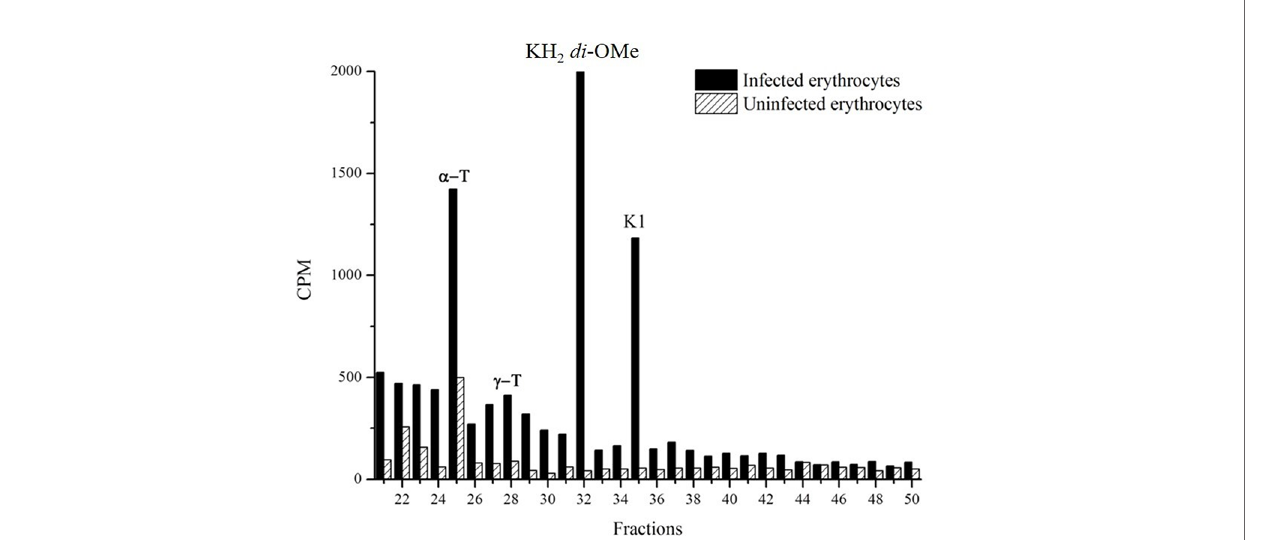
FIGURE 4 | Detection of methylated hydrophylloquinone. The hydrophylloquinone were stabilized by adding methyl iodide in infected erythrocytes extract labeled whit [ 3 H]-phytyl. After the extraction with dichloromethane, samples were analyzed by RP-HPLC (system I). Demonstration of the presence of radioactive fractions coincident with the standards a -T( a -tocopherol); g -T ( g -tocopherol); KH 2 di- O -Me (methylated hydrophylloquinone) and K1 (phylloquinone). The experiment was performed fi ve times with similar results.